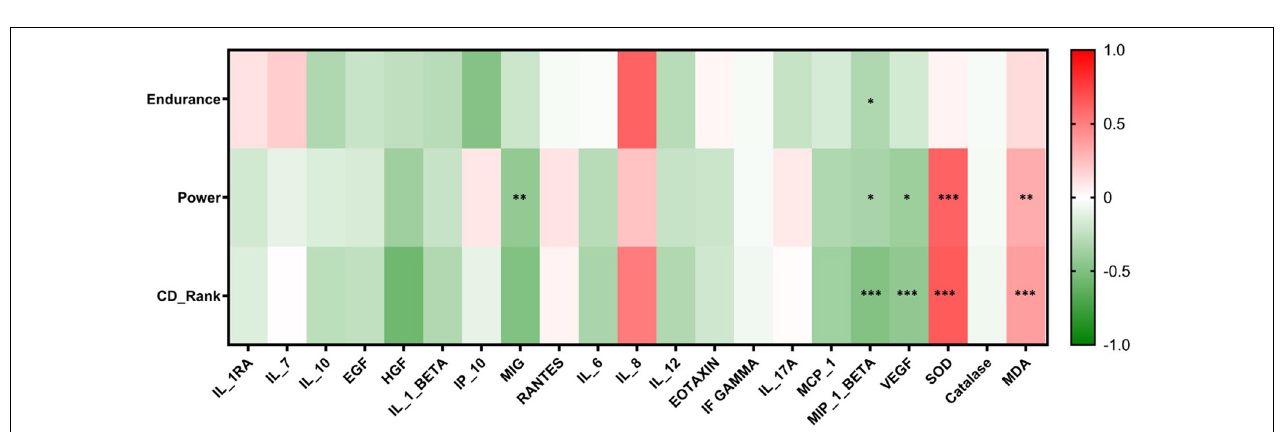
FIGURE 5 | Heatmap reflecting the significant correlations between study groups and cytokines and oxidative stress markers. Correlations were made using spearman’s correlation analysis (* p ≤ 0.05, ** p ≤ 00.01, *** p ≤